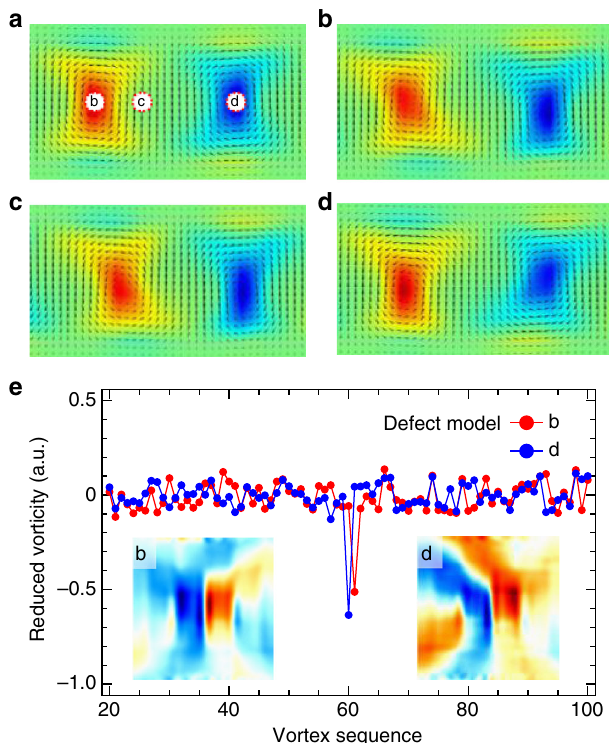
Fig. 5 Exploring single defect – vortex interaction. a – d Simulated vortex pair in the models containing null a and a single +2 q charge defect at different locations b – d as marked by dotted circles in a . The polarization vectors (arrows) are overlaid on the vorticity images. The fl exocoupling conditions derived above were included for this modeling. e The eigenvectors and loading maps (inset) of the fi fth PCA components of the defect models in b and d, analyzed from the full simulated vortex assemblies. In both cases, a spike in the eigenvector corresponds to the exact location of the defect and the loading map represent its main contribution to the vortex structure. Except for this and a few neighboring components that capture the perturbations to surrounding vortices (not shown), the other PCA loading map/eigenvectors are essentially identical for the two SSIM index proved to show better sensitivity for our problem over other commonly used image similarity metrics, such as Euclidean distance and Pearson's correlation coef fi cient.